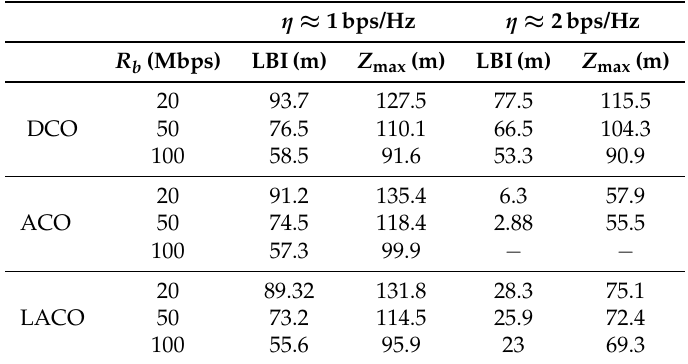
Table 6. LBI and maximum attainable range for DCO, ACO, an LACO-OFDM transmission schemes according to Figure12; BER = 10 − 3 .